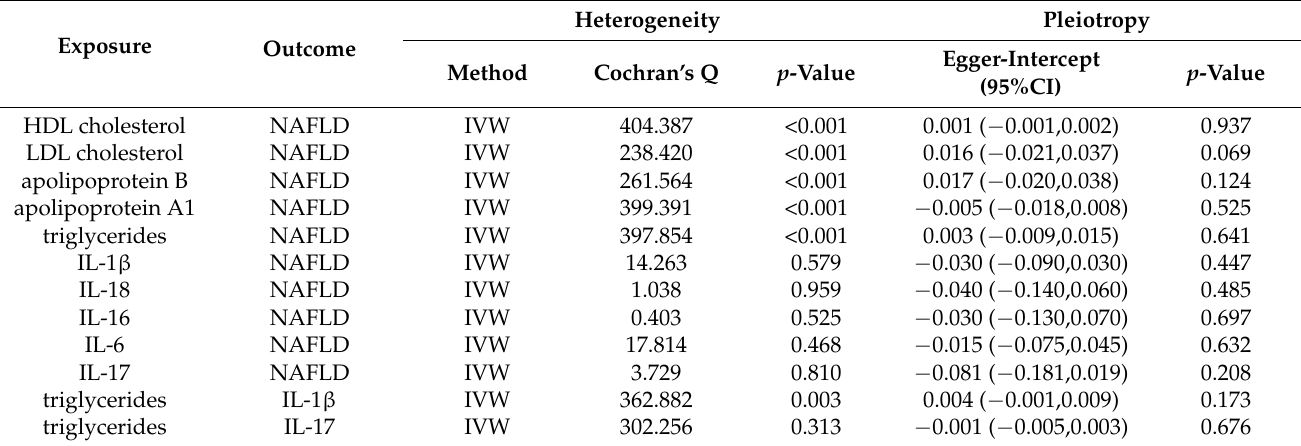
Table 3. Heterogeneity and pleiotropy analysis.